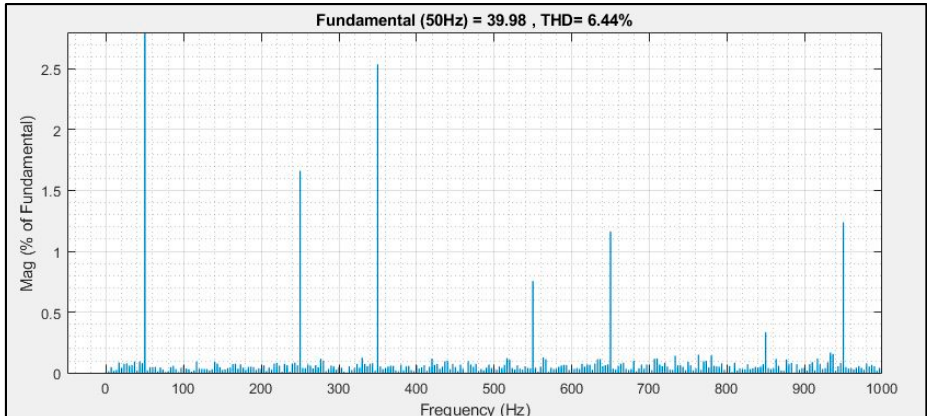
Figure 19. Source current THD using DSTATCOM with a PI Controller. Table 4. Source current THD for various conditions.